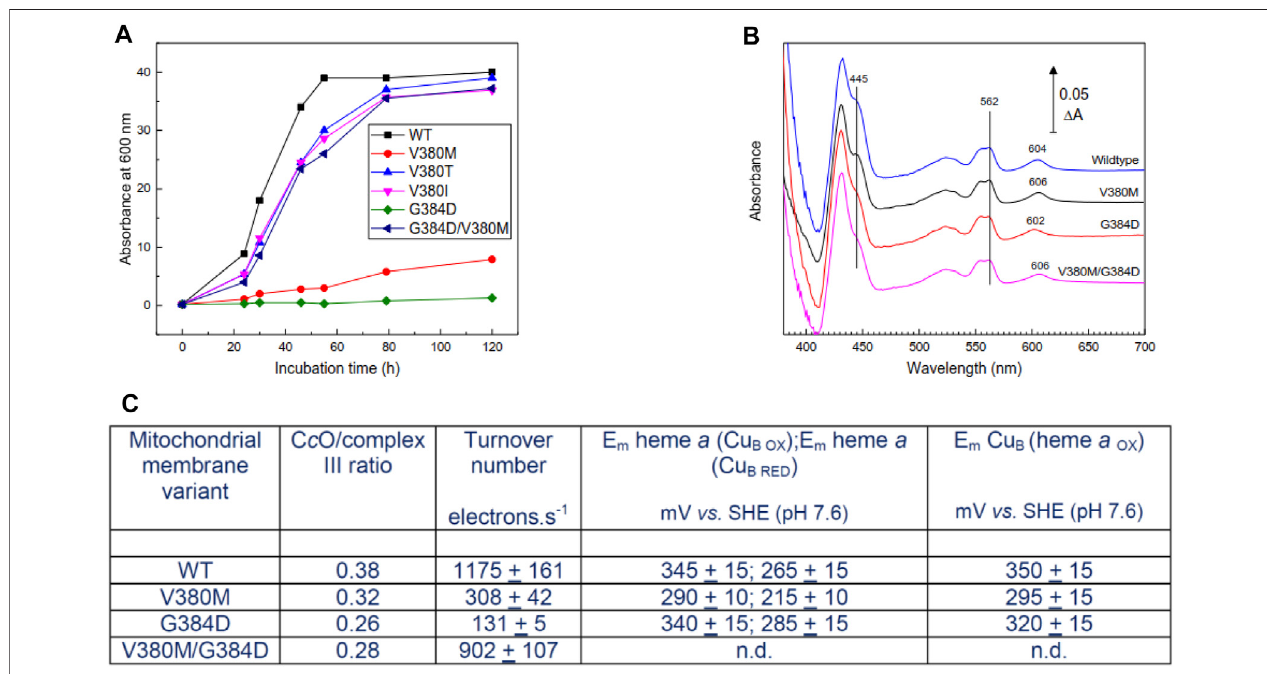
FIGURE 2 | Properties of mutant yeast cells and mitochondrial membranes. (A) Respiratory growth rates of intact yeast cells in ethanol — containing medium. (B) Dithionite-reduced minus oxidized spectra of mitochondrial membranes derived from WT and mutant cell lines. Spectra were normalized to the same complex III concentrations assessed from Δ A at 562 – 575 nm. The602 – 606 nm bandarisesprimarilyfrom heme a ; hemes a and a 3 contribute roughlyequally tothe 445 nm band. (C) SummaryofratioofC c O/complexIII,C c Oturnover numbers and redox propertiesofmetal centersofC c Oinmitochondrial membranes. Speci fi cexperimental details for all panels can be found in Methods. n.d. – not determined, but expected to resemble